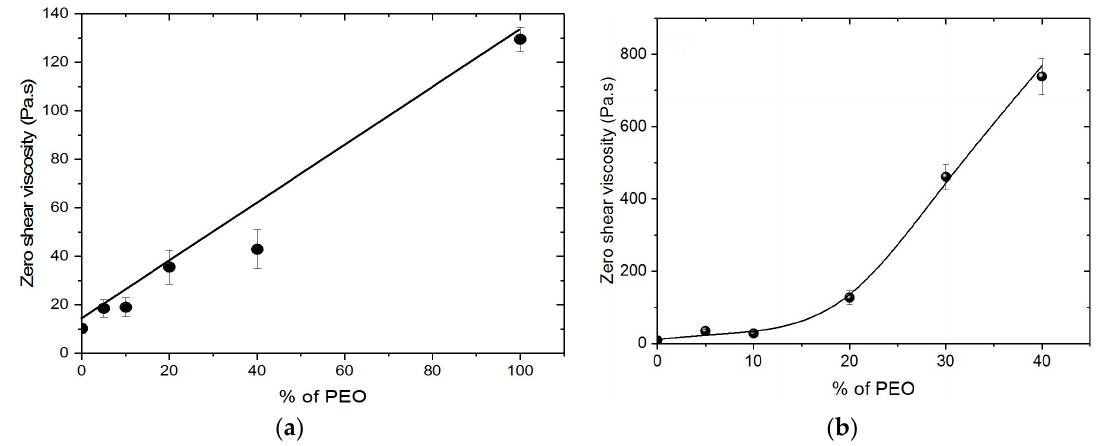
Figure 1. Zero shear viscosity at 20 °C for solutions prepared for films and fibers production as a function of w / w % of PEO in the blend. T = 20 °C. ( a ) By mixing 5% solutions of chitosan and 5% solution PEO in 0.5 M acetic acid; ( b ) by addition of powder PEO in 5% chitosan solution.